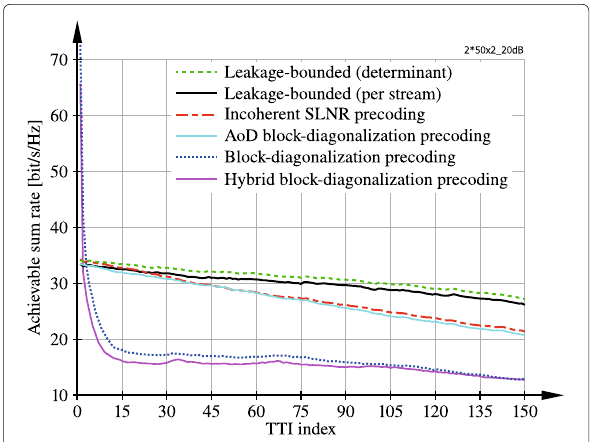
Fig. 5 Time-evolution of the achievable rate of different precoding schemes assuming constant precoders over time and time-variant